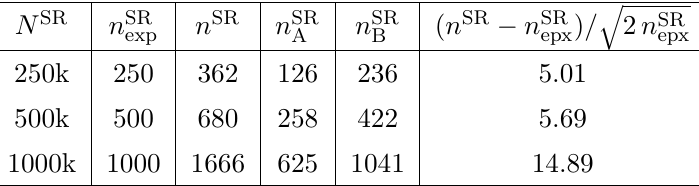
Table 3 . Same as table 1 but for a fixed fraction f SR = 0 . 01 of anomalous events in a signal region with N SR